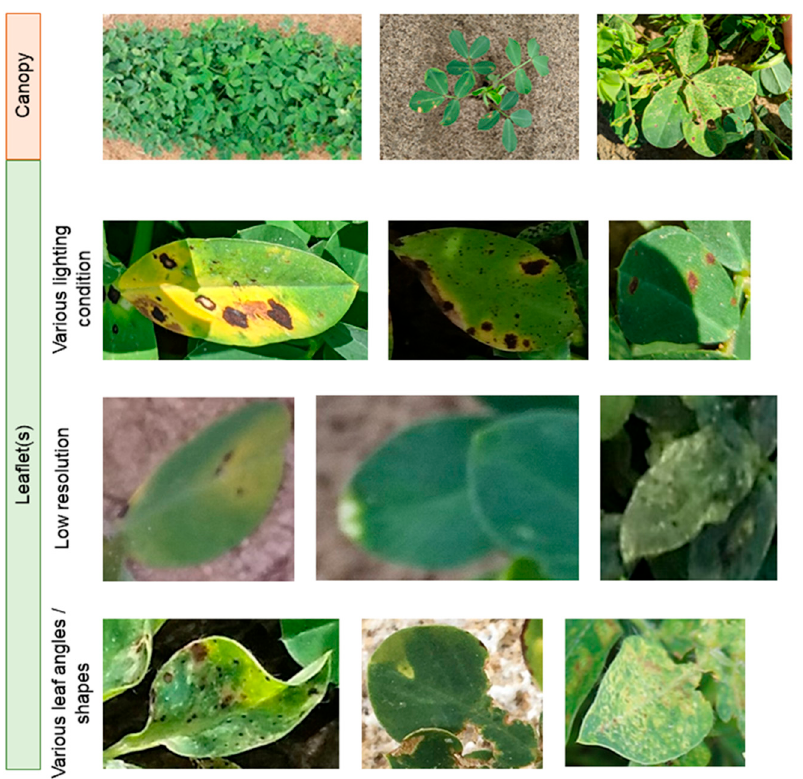
Figure 1. Examples of canopy and leaflet images from different angles, resolution quality, and lighting included for developing the models.